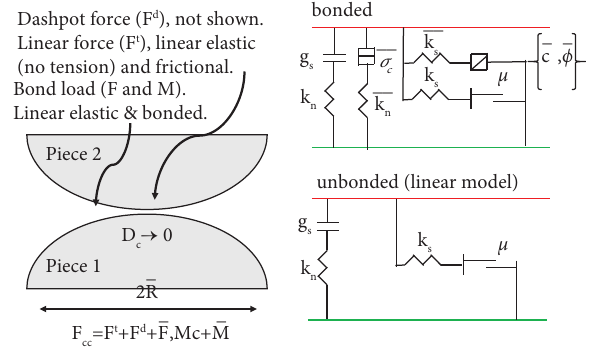
Figure 1: Schematic of the contact model.